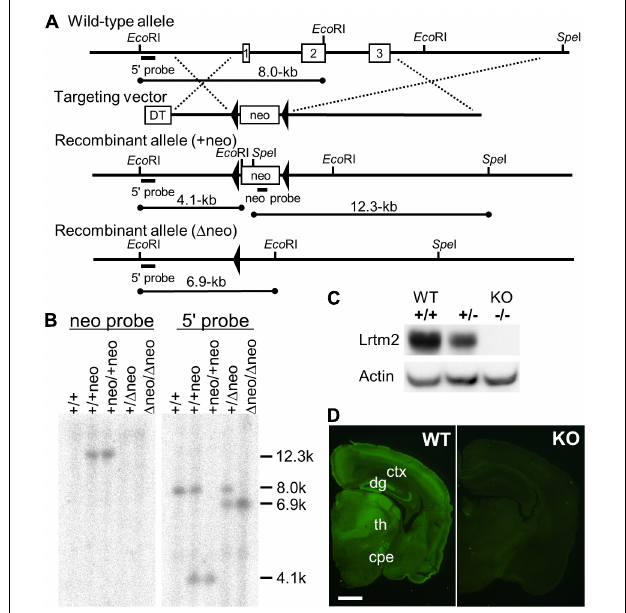
FIGURE 1 | Targeted disruption of the Lrtm2 gene. (A) Structures of the Lrtm2 genomic locus, targeting vector, and mutated allele. The locations of the probes for Southern blotting (5’ and neo probes) are shown. DT, diphteria toxin A; neo, neomycin-resistance gene. (B) Confirmation of homologous recombination of the mutant alleles by Southern blot. (C) Western blot performed on proteins prepared from brains of adult Lrtm2+/+ (WT), Lrtm2+/-, and Lrtm2 − / − (KO) mice. (D) Immunostaining of Lrtm2 KO brain using anti-Lrtm2 antibody. 8 weeks-old. WT, littermate control. cpe,